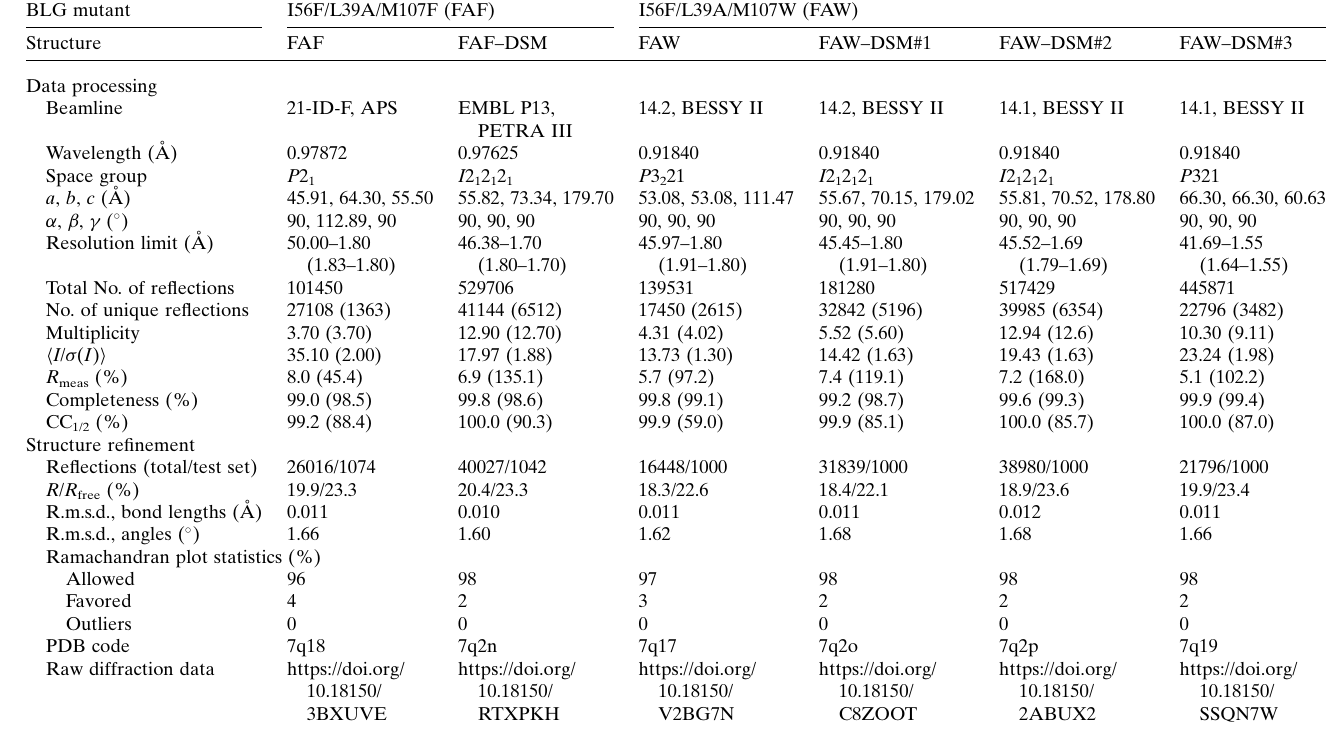
Table 1 Data-collection and structure-refinement statistics. Values in parentheses are for the highest resolution